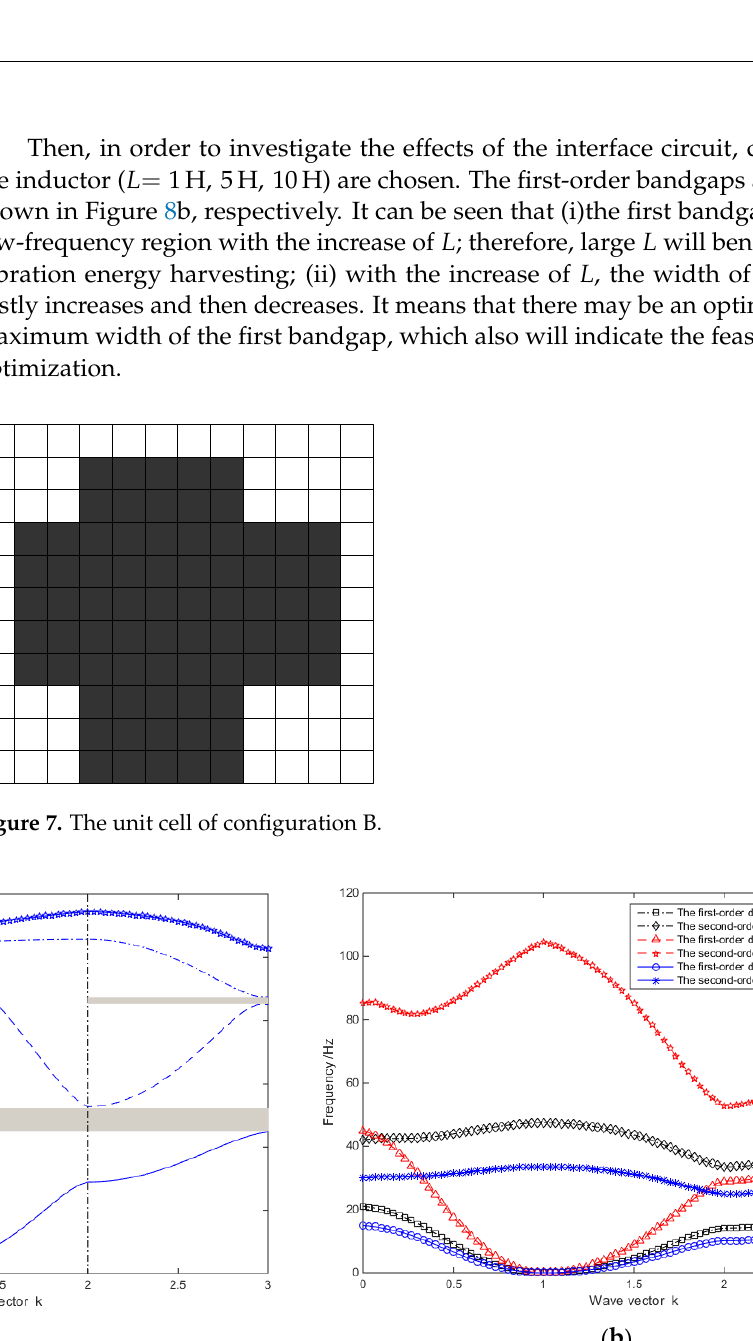
Figure 6. The dispersion curves under configuration A.